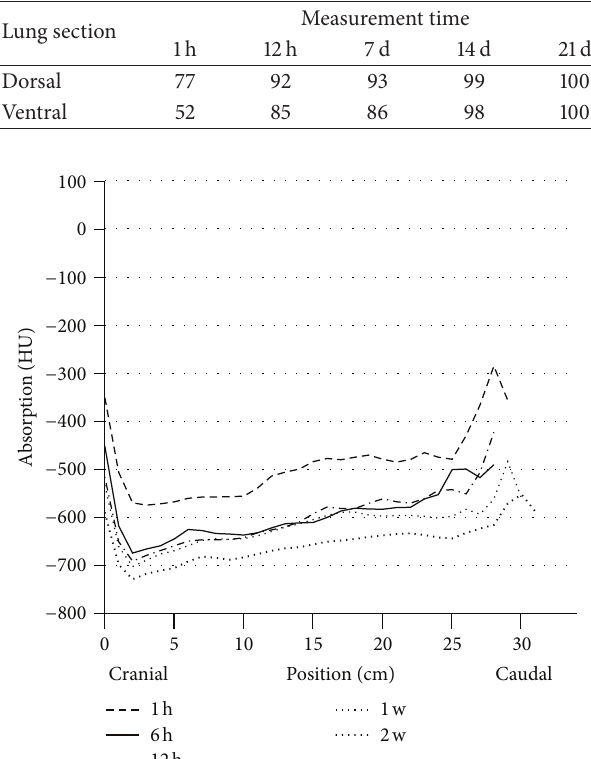
Table 6: Percentile development of the gas exchange capacity, mea- sured by detectable HU in the first 3 weeks p. n.